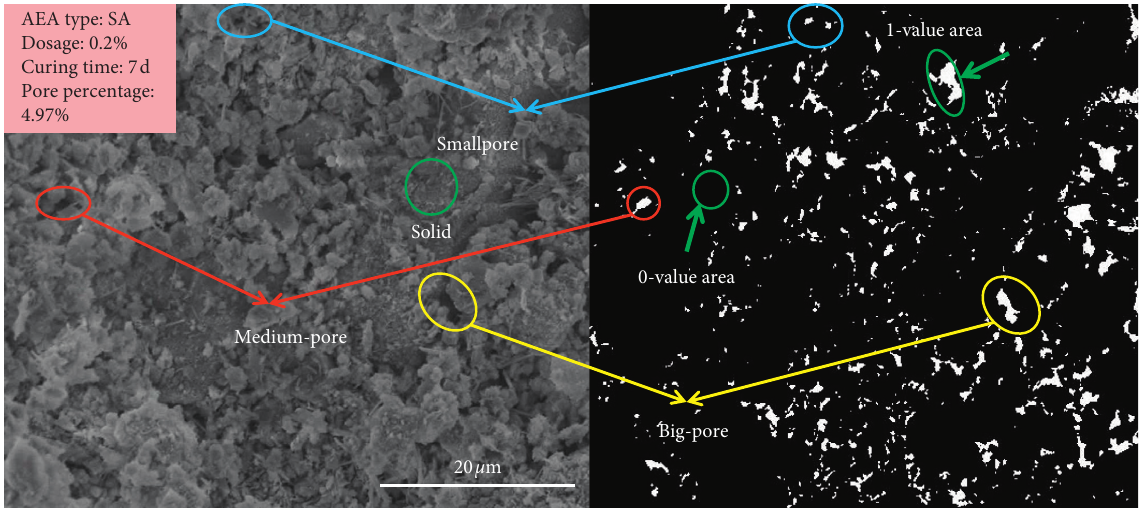
Figure 5: SEM and its binarization image of AEACPB.